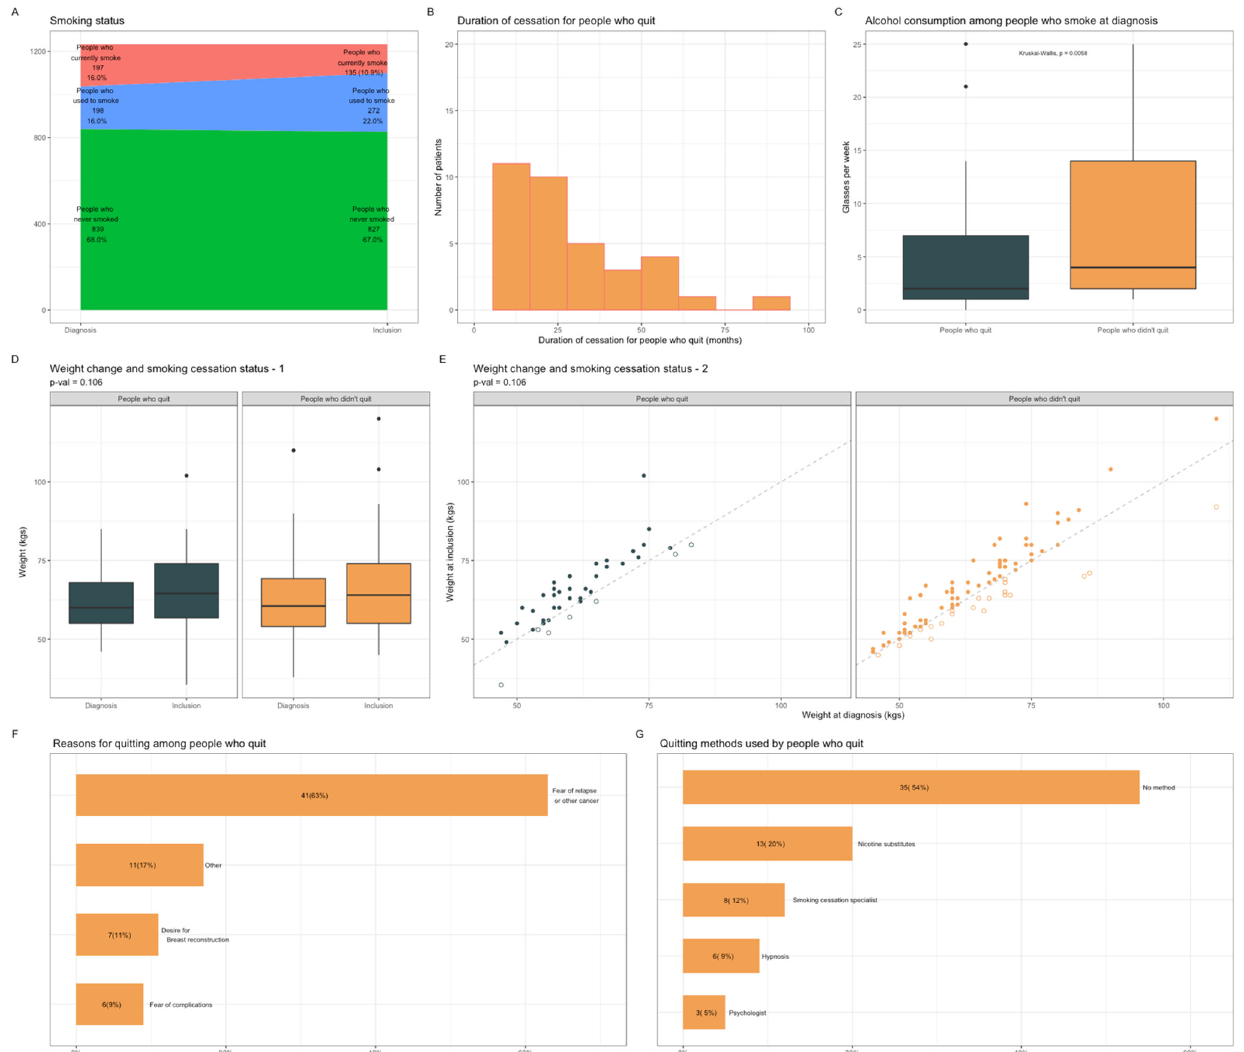
Figure 3. Population characteristics according to smoking cessation status after BC diagnosis. ( A ), Patients’ repartition according to smoking status at the time of diagnosis and at inclusion. ( B ), Smoking cessation duration among patients who quit smoking ( n = 65). ( C ), Alcohol consumption among patients who currently smoke at diagnosis according to smoking cessation status. ( D ), Mean weight changes between diagnosis and study inclusion according to smoking cessation status. ( E ), Scatter plot representing weight changes since BC diagnosis according to smoking cessation status after diagnosis. Full circles representing patients who have gained weight; empty ones, patients who have lost weight. ( F ), Smoking cessation motivations among patients who quit smoking ( n = 65). Prespecified subcategories were: Fear of relapse or other cancer; Desire of a healthier life (Other); Desire of breast reconstruction and Fear of complications. ( G ), Smoking cessation methods among patients who quit smoking ( n = 65). Subcategories were: No method; Nicotinic substitutes; Tobacco consultations; Alternative methods (Hypnosis); Consultation with a psychologist. Abbreviation: BC, breast